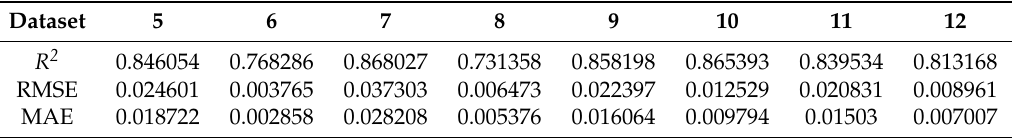
Table 4. Statistical performances of FNN model (for testing data) along the flume (x-direction).